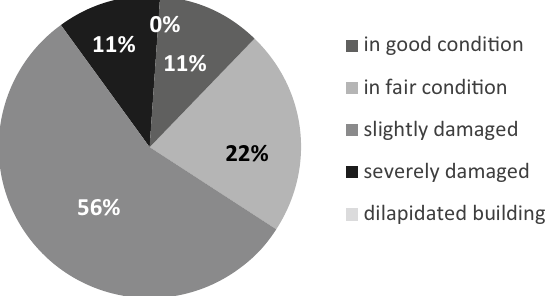
fig. 1. The varied conditions of designated Shikumen houses Source: Shanghai Municipal Housing Bureau